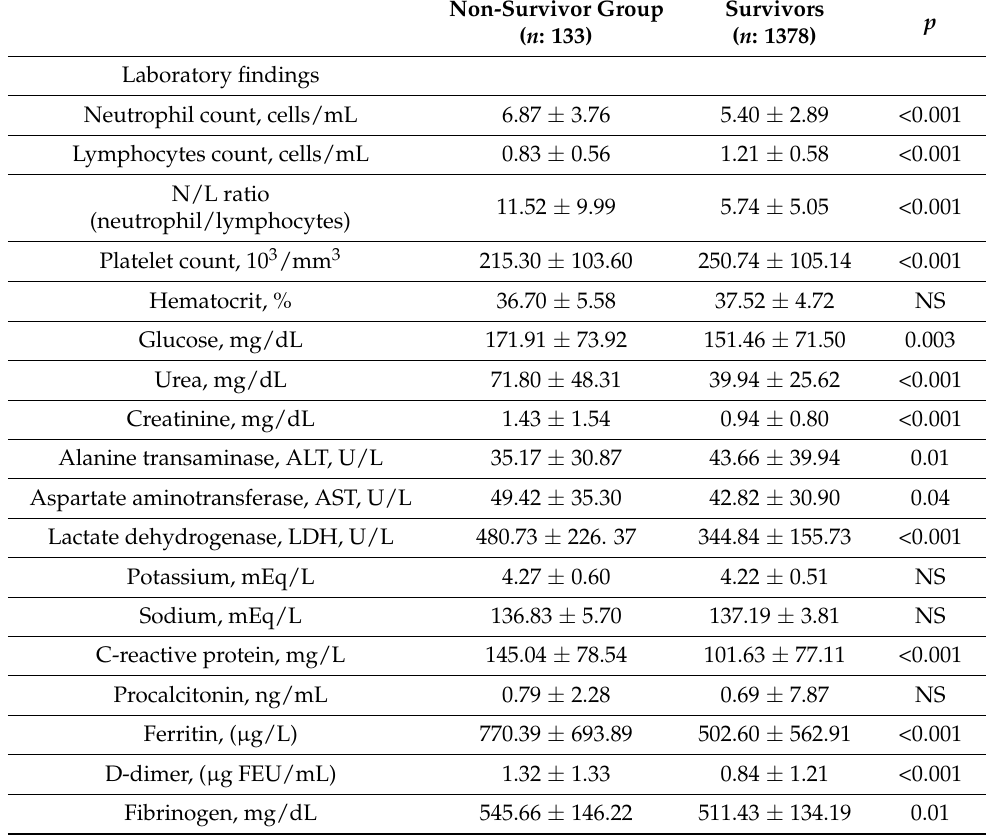
Table 2. Laboratory findings, CT scores, disease severity status and outcomes of the